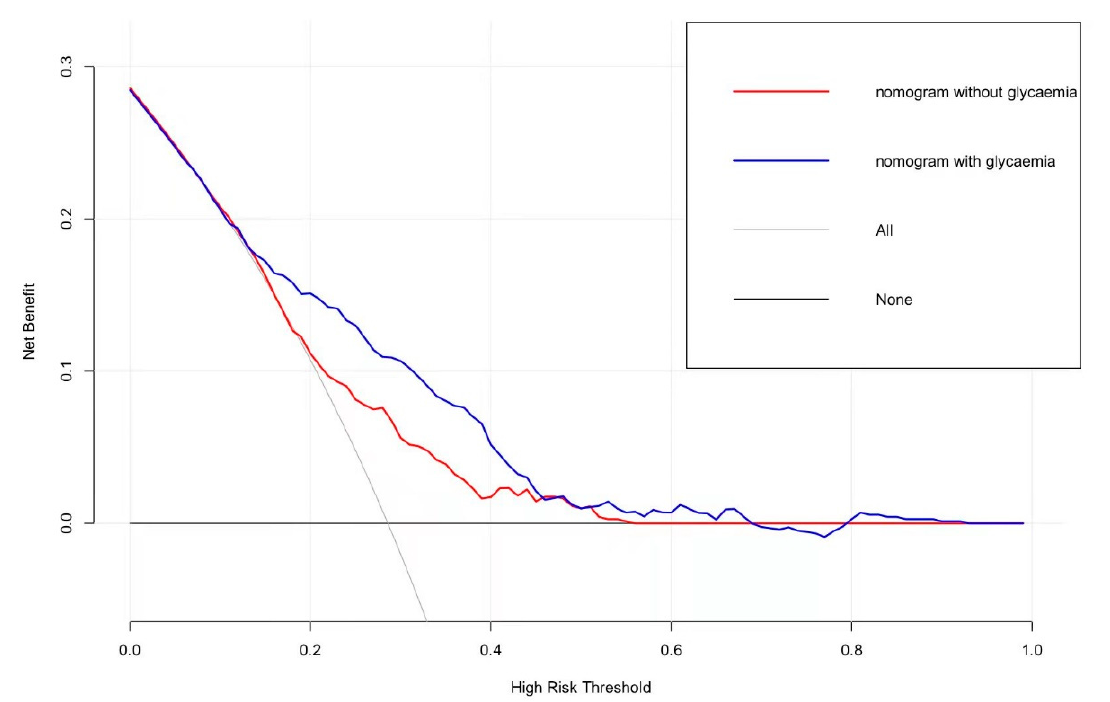
Figure 4. Decision curve analysis for the nomogram.